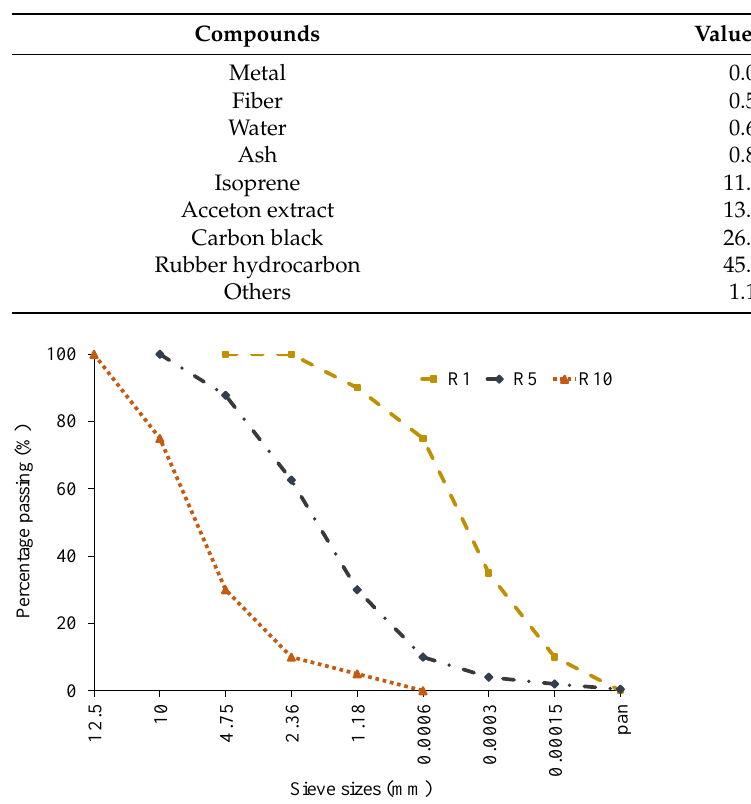
Figure 3. Sieve analysis of the used rubber waste. Table 3. Technical details of the used superplasticizer. Table 2. Chemical composition of the used rubber.